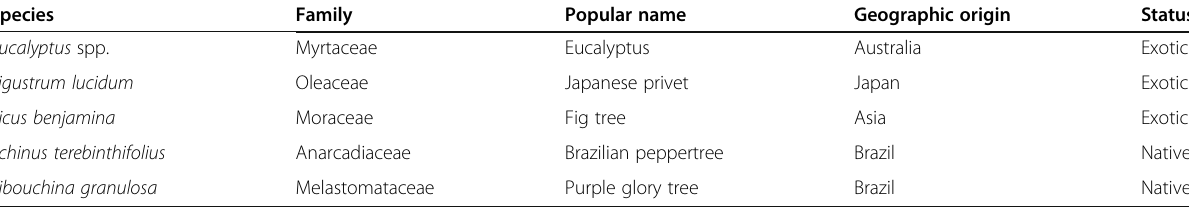
Table 2 Taxonomic and biogeographic characteristics of the chosen species in the present study Species Family